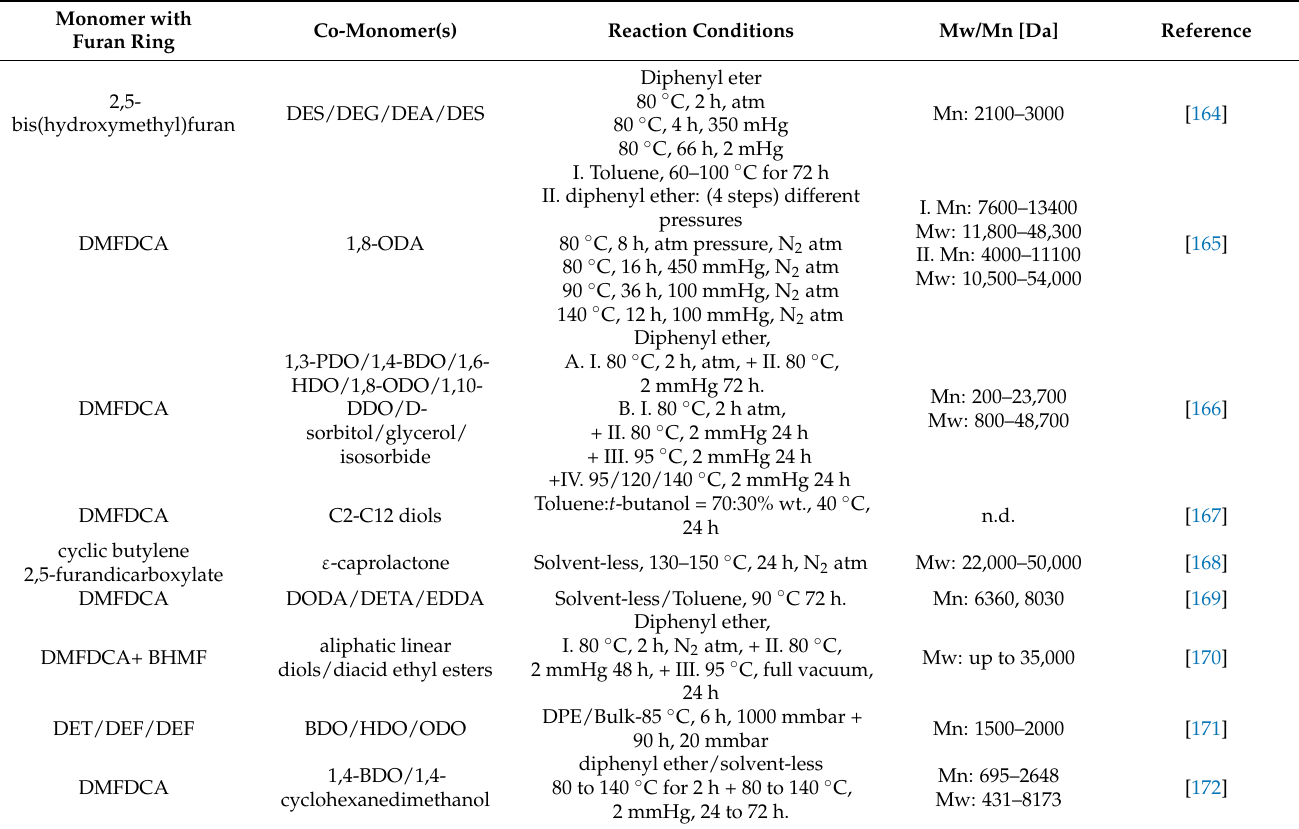
Table 5. The enzymatic synthesis of polyesters containing furan moieties, using Novozyme 435 as biocatalyst. Monomer with Furan